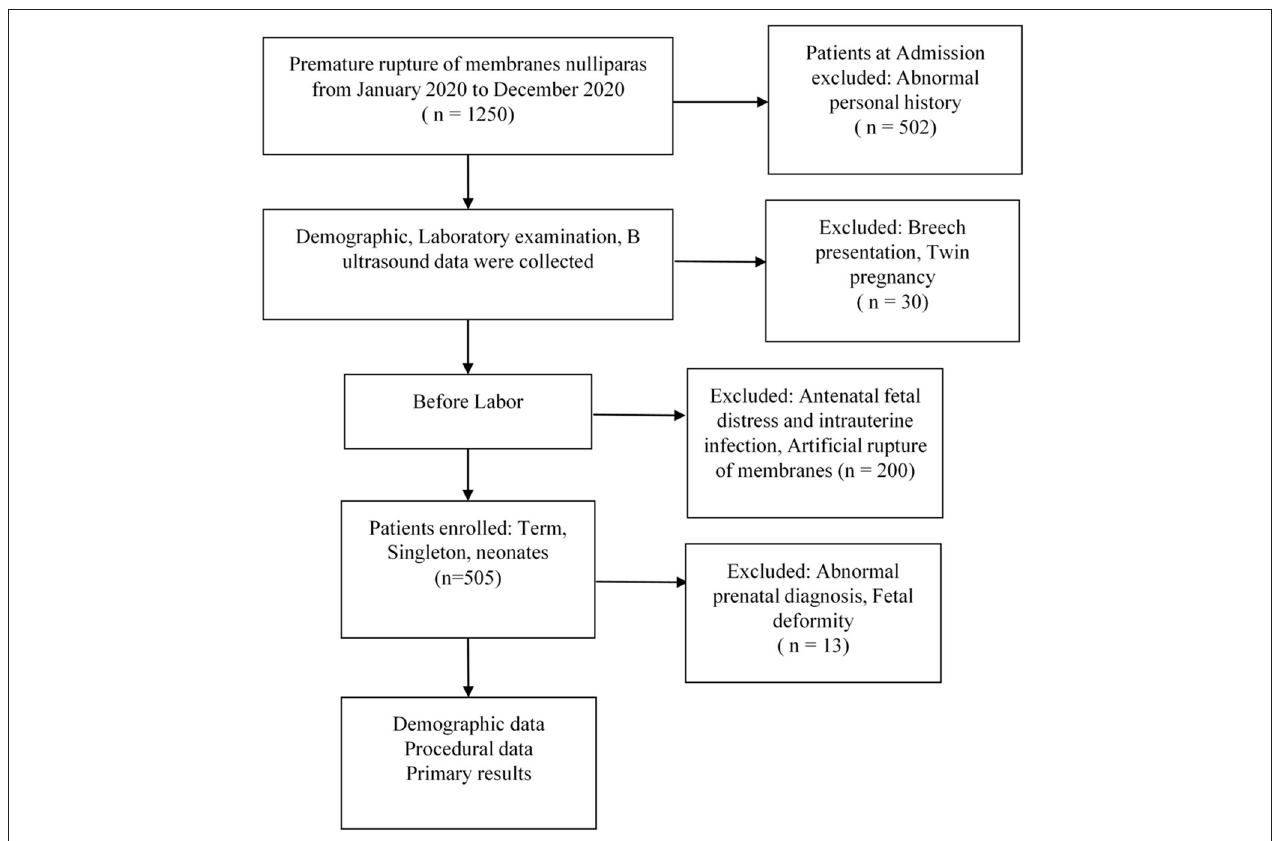
FIGURE 1 | Study flow